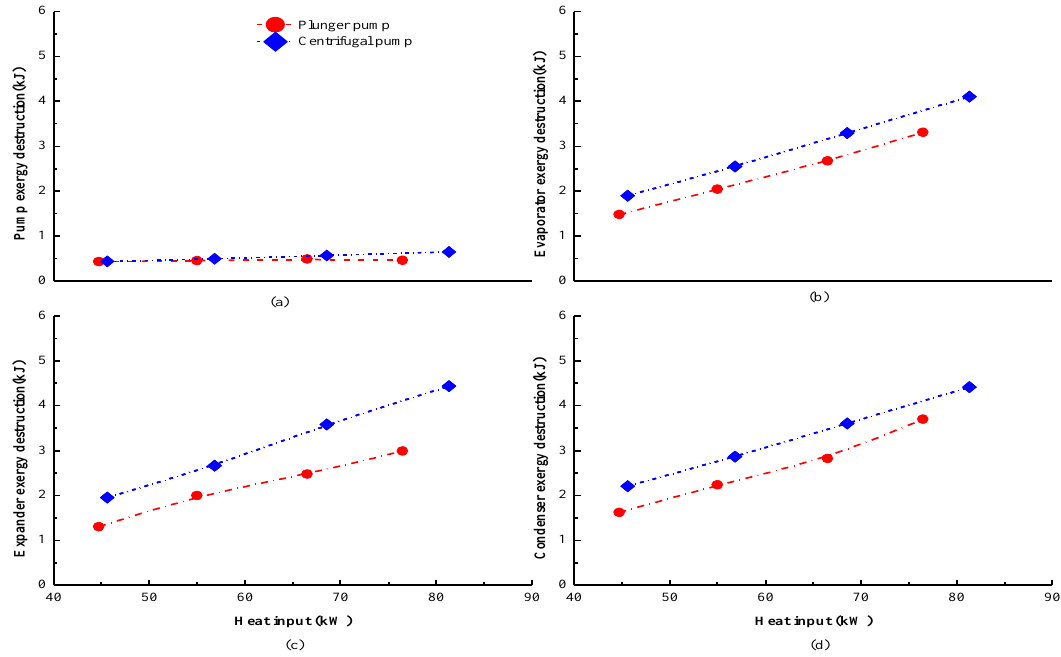
Figure 15. Exergy destruction of the four important components using the plunger pump and centrifugal pump: ( a ) pump exergy destruction; ( b ) evaporator exergy destruction; ( c ) expander exergy destruction; ( d ) condenser exergy destruction. Figure 16. For the plunger pump and centrifugal pump, the exergy destruction for the evaporator, expander and condenser is almost 30%, indicating that improving the temperature matching between the cycle and the heat (cold) source is a way to improve the system property.